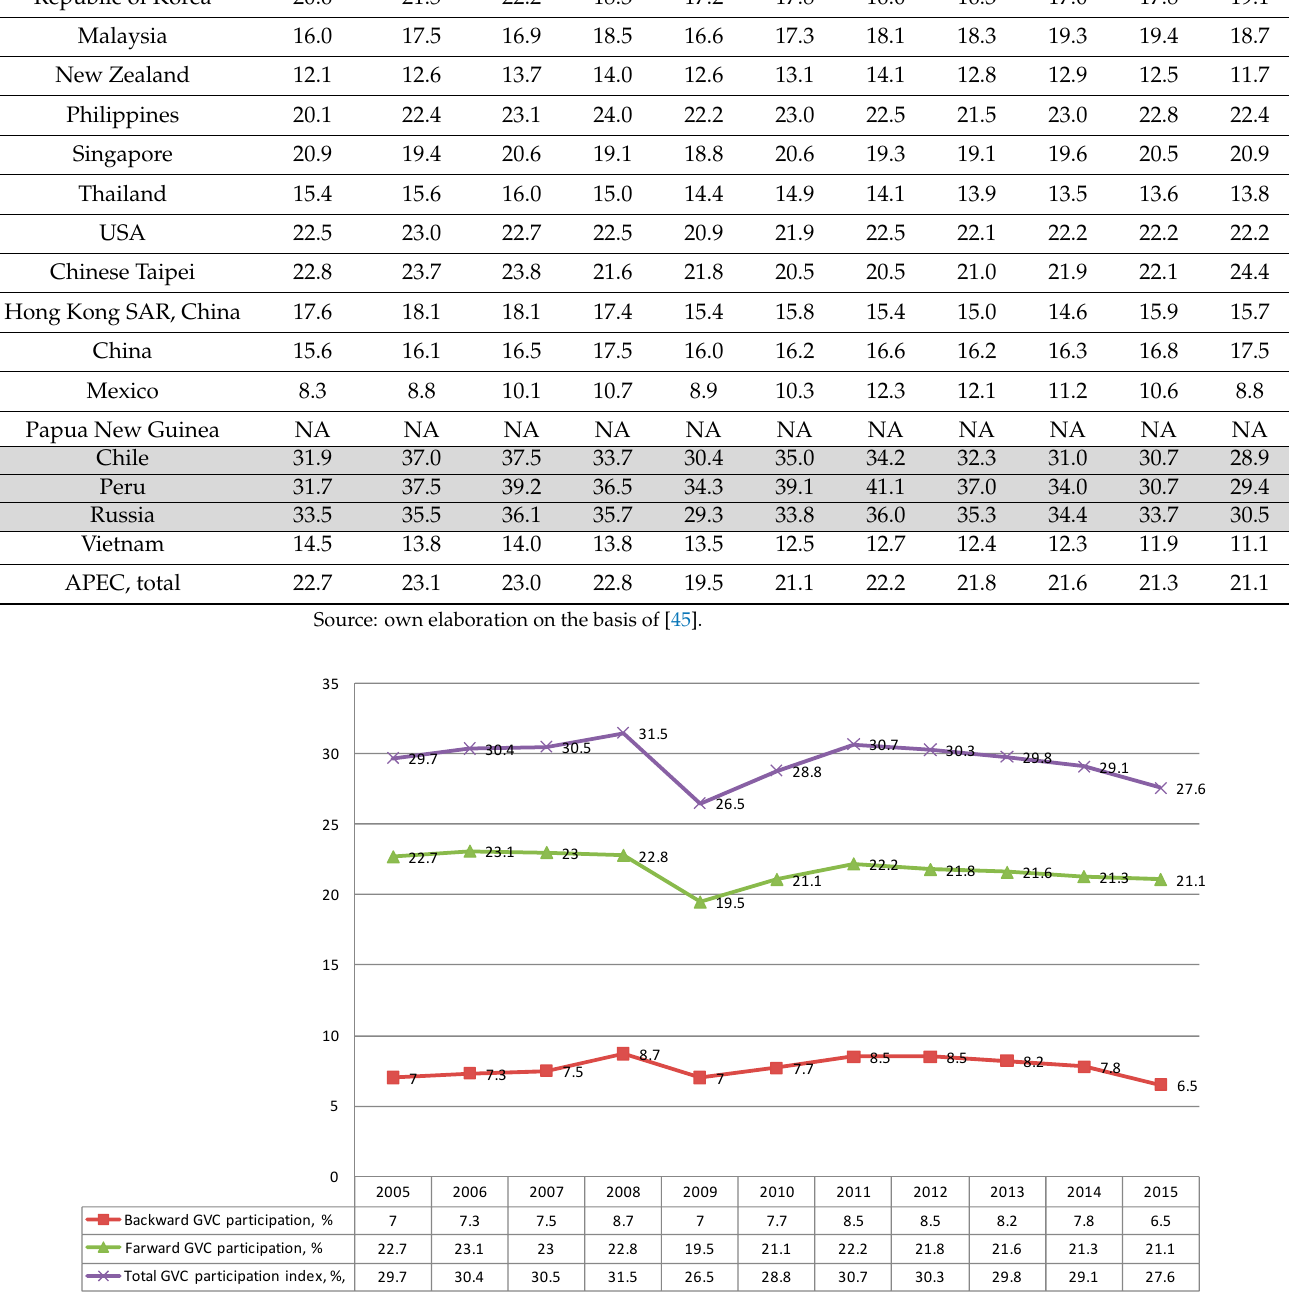
Figure 2. APEC member economies’ GVC participation, 2005–2015. Source: own elaboration on the basis of [45].